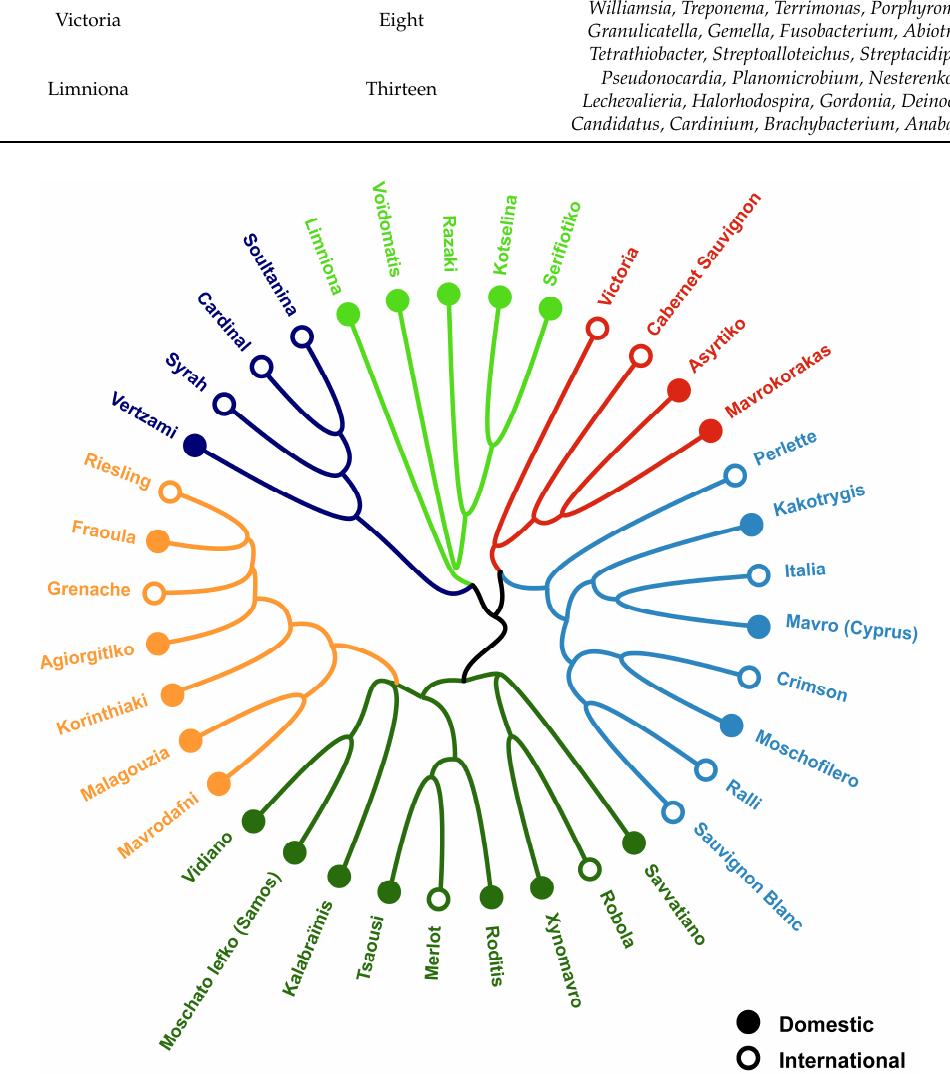
Figure 4. Hierarchical Cluster constructed using Bray-Curtis at the genus level for 37 grapevines.